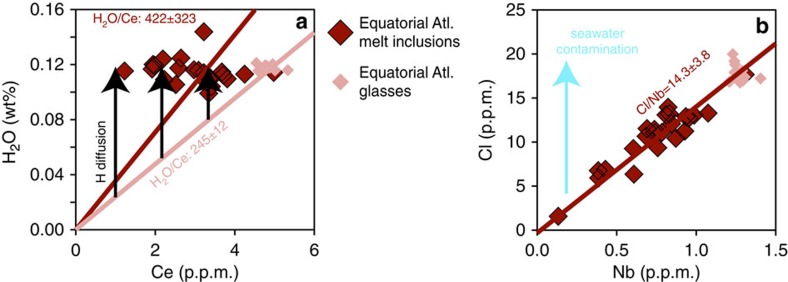
Behaviour of H2O and Cl in the equatorial MAR melt inclusions.(a) Variation in H2O content (wt%) as a function of Ce content (p.p.m.) for the equatorial MAR melt inclusions and matrix glasses. (b) Variation in Cl content (p.p.m.) as a function of Nb content (p.p.m.) for the equatorial melt inclusions and matrix glasses.